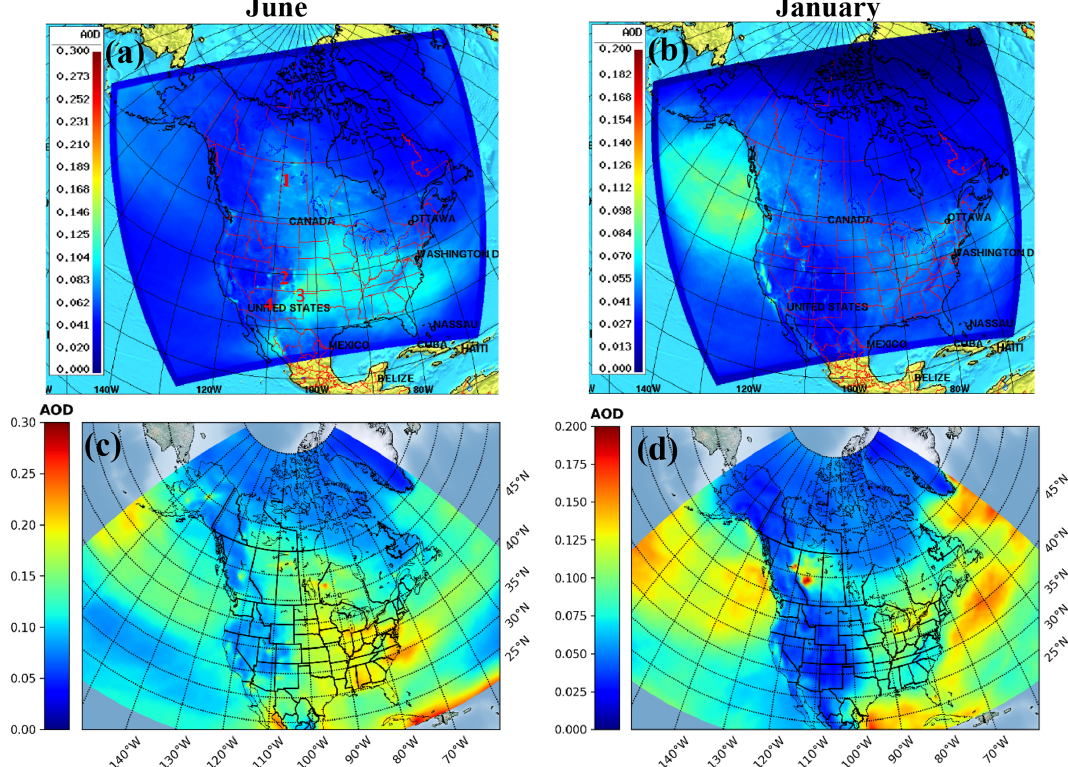
Figure 9. Monthly average daytime AOD at 580nm from GEM-MACH and MERRA-2 model. Left column: June 2018 (a) GEM-MACH AOD (c) MERRA-2 AOD. Right column: January 2018 (b) GEM-MACH AOD (d) MERRA-2 AOD. Four major forest fire events in June 2018 shown in GEM-MACH output (a) : (1) Lac La Loche forest fire, (2) 416 fire, (3) Ute Park fire and (4) Gila National Forest fire. (cid:17) (cid:16) J × 100 AOD − J no-AOD Table 5. Statistical scores of percentage difference of J (O 1 D), with and without AOD calculations at the Fort (J AOD + J no-AOD )/ 2 McKay and Toronto AERONET stations from the 1-month GEM-MACH J (O 1 D) output at the lowest model level in June 2018. Percentage difference in J (O 1 D) With aerosol feedbacks Without aerosol feedbacks Fort McKay Toronto Fort McKay Toronto Standard deviation 29.25 28.7 0.213 0.547 Mean − 0 . 96 − 0 . 65 − 0 . 006 0.035 Median